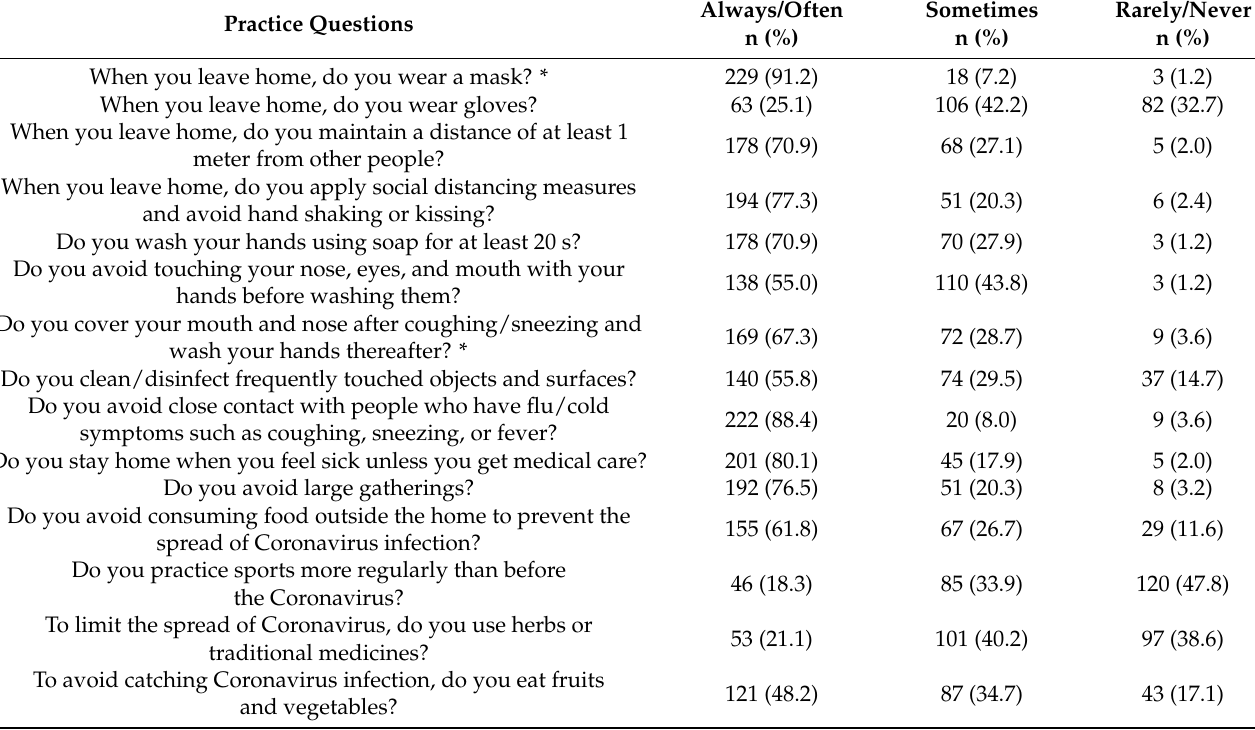
Table 7. Patients’ responses to questions related to practices of prevention from COVID-19 (n =